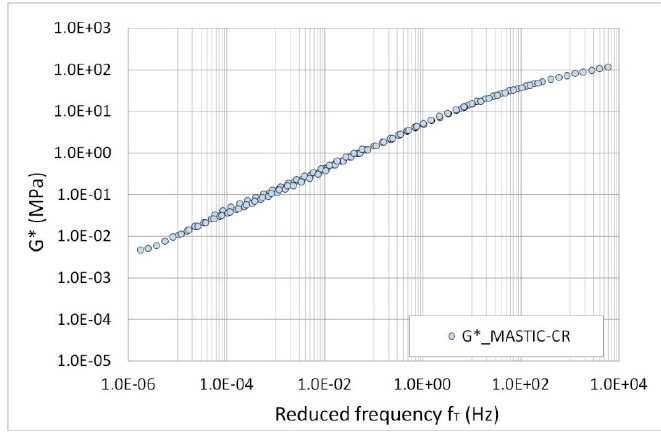
Figure 7. MASTIC-CR master curve at 20 °C.